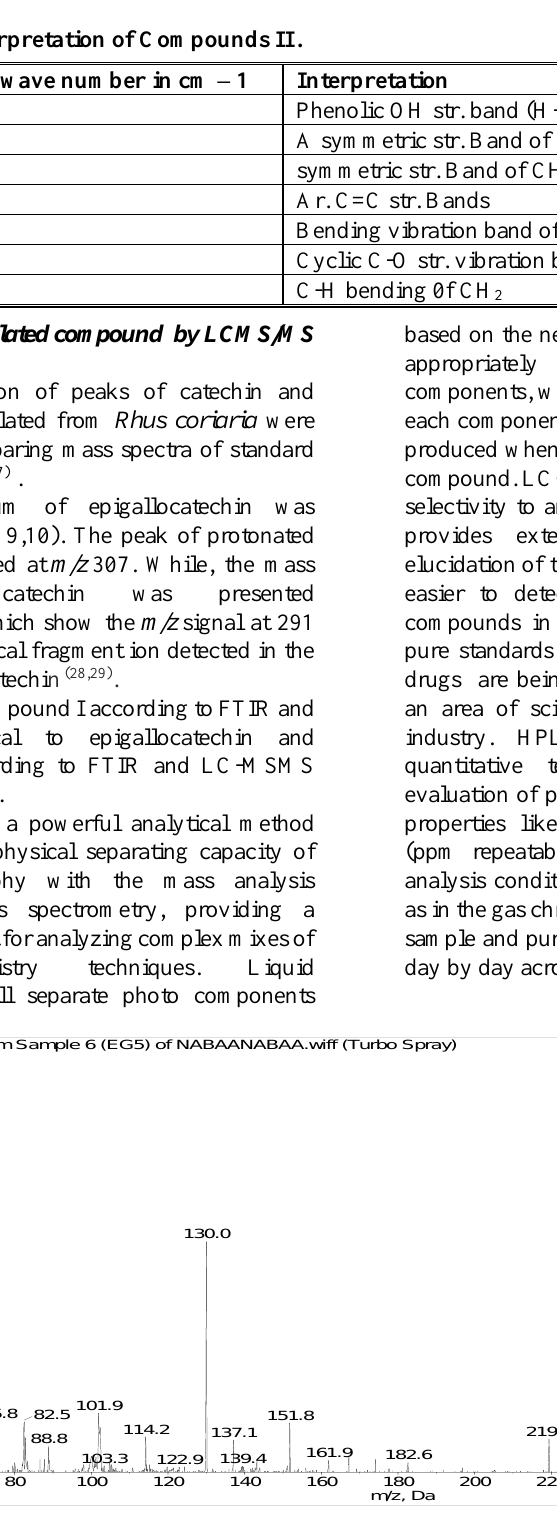
Figure 9.LC-MSMS of Compound